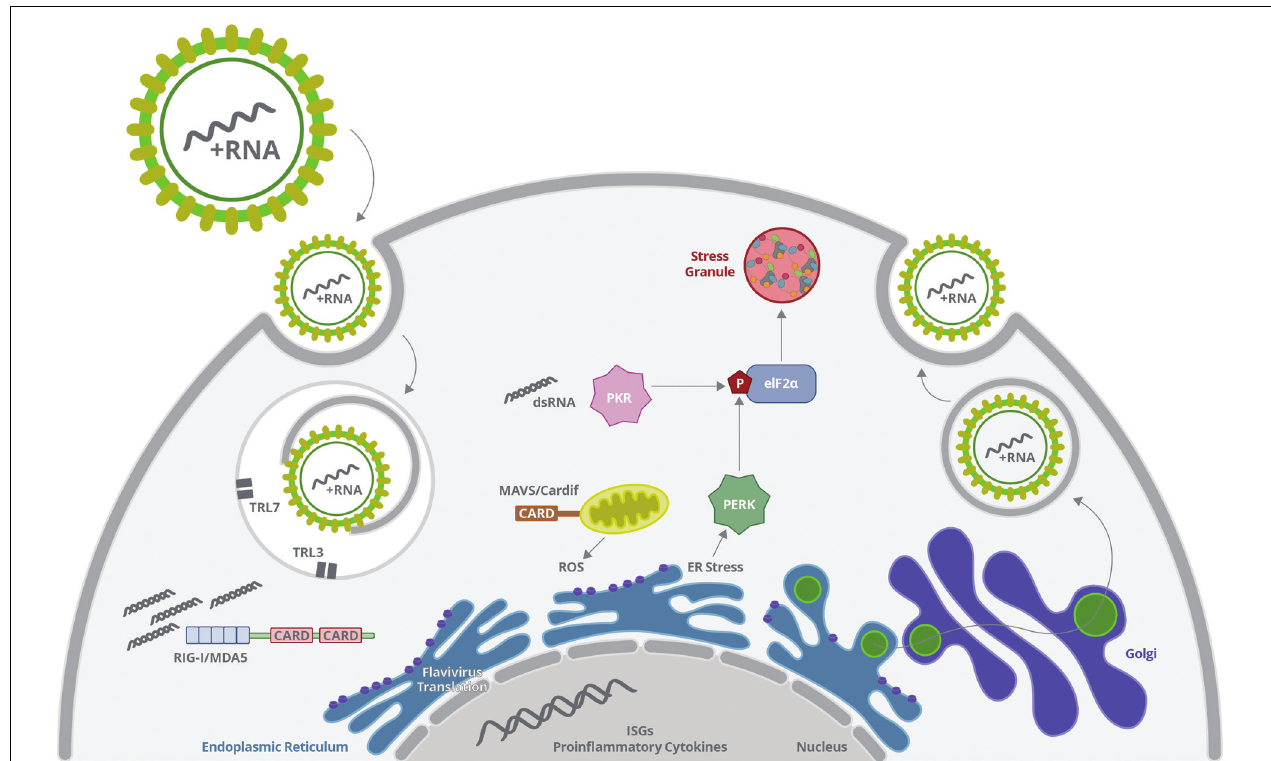
FIGURE 5 | Flavivirus infection is initiated by virus endocytosis, envelope fusion and genome uncoating, releasing virus RNA. Genomic RNA or dsRNA generated during replication may be sensed by vesicular TLR, RIGI, MDA5, or PKR. Activation of TLR and RIG-I promotes ISG and inflammatory genes expression; whereas PKR stimulation promotes eIF-2 α phosphorylation and stress granules formation. In parallel, virus protein translation takes part mostly at the ER, altering ER homeostasis and promoting UPR. Virus sensing and replication affect mitochondrial function, inducing increased ROS production and oxidative stress, what may activate other inflammatory signal and affect cell survival. Virus scape mechanisms are triggered at different levels in different cell types, allowing some level of progeny